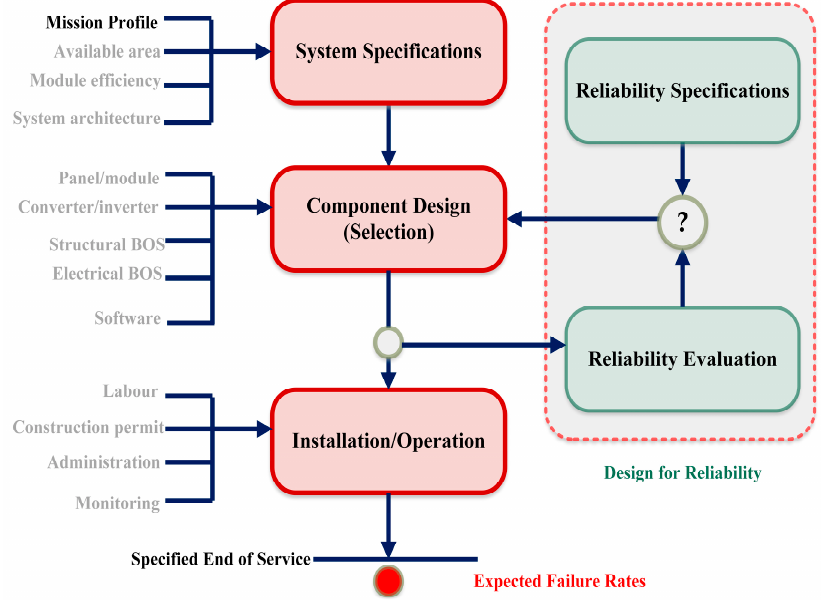
Figure 31. Design for reliability process fl ow diagram for power electronics in PV systems.